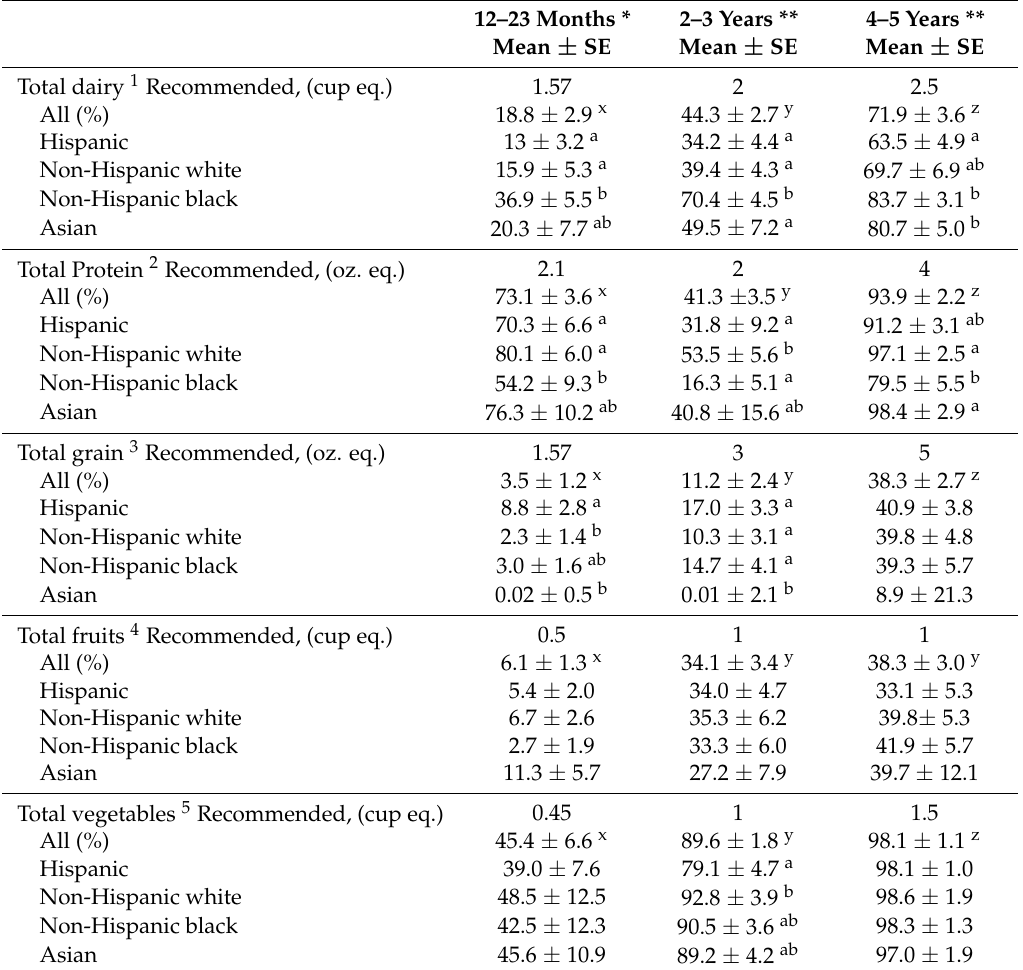
Table 4. Percent of children below the recommended intake of food groups by age and ethnicity, NHANES